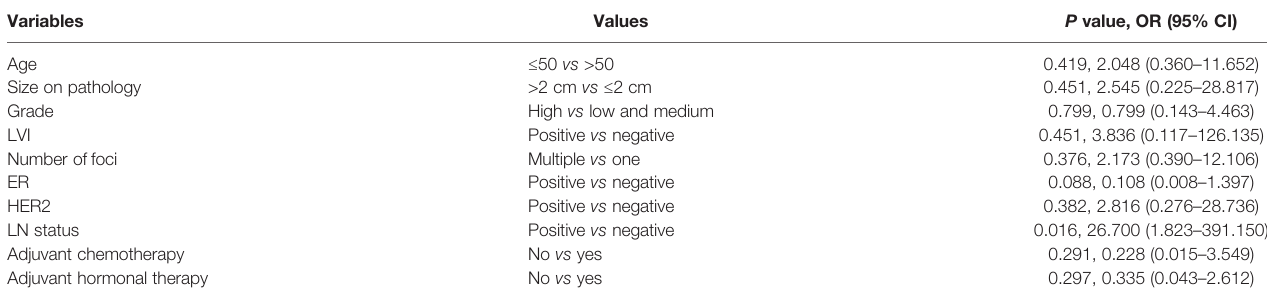
TABLE 4 | Multivariate analysis via Cox regression model for independent predictors on DFS.